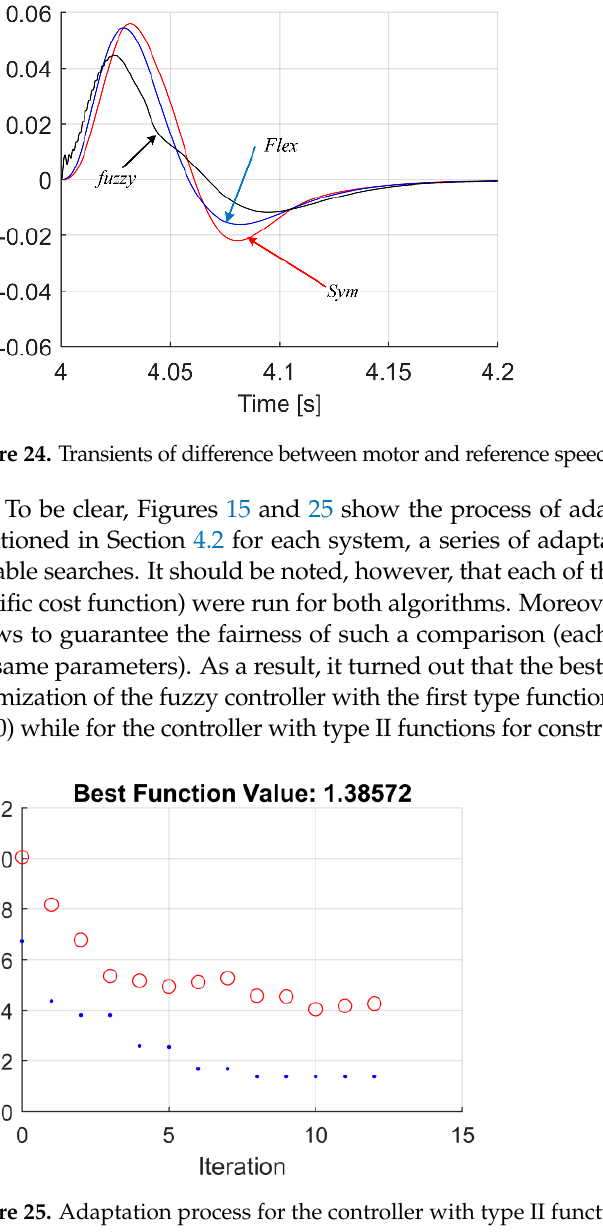
Figure 23. Transients of difference between motor and load speed for case of reference speed change.